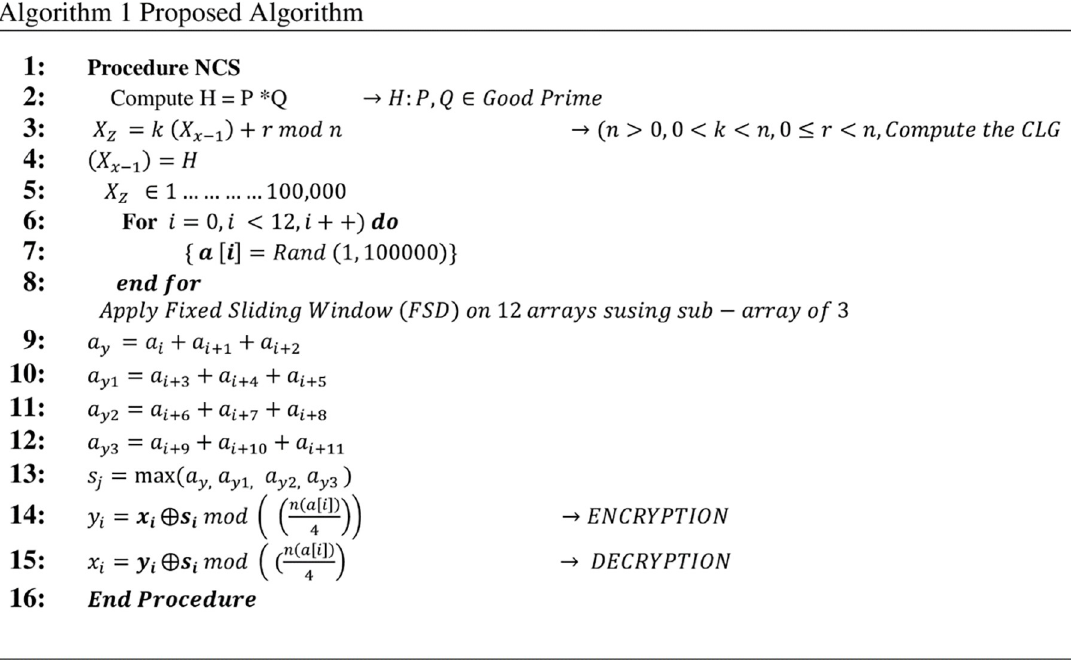
Fig 6. The proposed NCS algorithm.